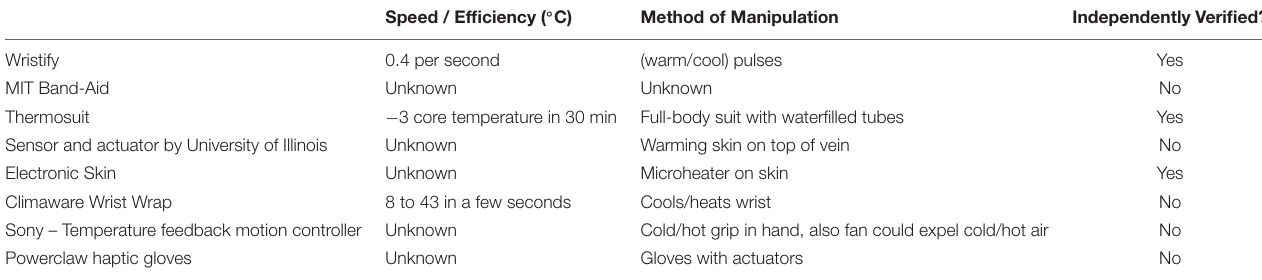
TABLE 2 | Specifications of possible actuator devices to be used in co-thermoregulation research and therapy. Speed / Efficiency ( ◦ C) Method of